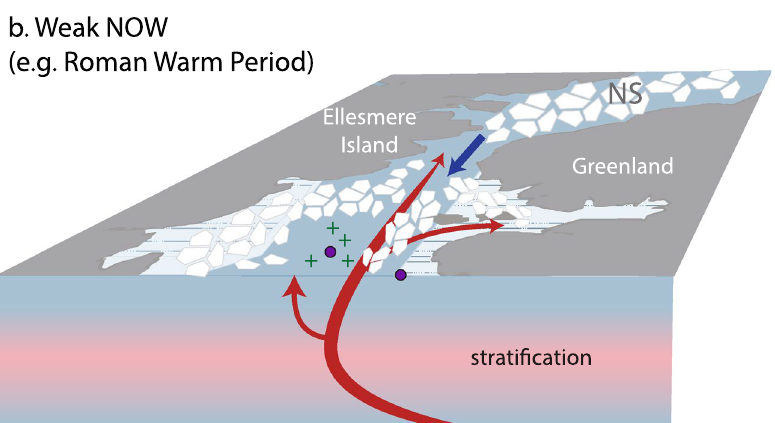
bottom waters. Instead, this points to a highly stratified water column; the advection of saline Atlantic water (at intermediate depth) preventing deeper mixing and leading to a poorly ventilated sediment/water interface bathed in dense, cold waters that would promote biogenic carbonate dissolution. Unlike mid-Holocene increases in WGC strength that were not reflected in our records during the period of strong NOW formation, we attribute the increasing influence of Atlantic water in the NOW region from ~ 1800 yrs BP to reflect the reduced capacity of a weakened NOW to mediate local ocean circulation during warm climatic intervals (Fig. 8b). During the latter part of the Little Ice Age (LIA), increases in sea ice (IP 25 ) are recorded at the peripheral polynya site, suggesting the potential presence of a stable ice arch. Despite a slight decrease in the proportion of benthic Atlantic water species, there appears to be no strong imprint of NOW recovery on bottom ocean conditions. Furthermore, biological productivity did not recover to levels recorded during the previous period of stable NOW formation, despite regional records indicating the return of (smaller) little auk colonies 16 . Over the last ~ 150 years however, increasing biological productivity at the central NOW site, as well as decreasing Atlantic water influence, indicate a somewhat strong NOW. Conversely, at the margins of the NOW, Atlantic water influence and stratification persisted, and enhanced seasonal sea-ice cover is inferred from increasing IP 25 fluxes (Fig. 7). Organic matter 59 and dinoflagellate cyst concentrations 8 were more variable in the polynya periphery, suggesting that its margins were dynamic and productivity was not spatially homogenous (e.g. 7 ).